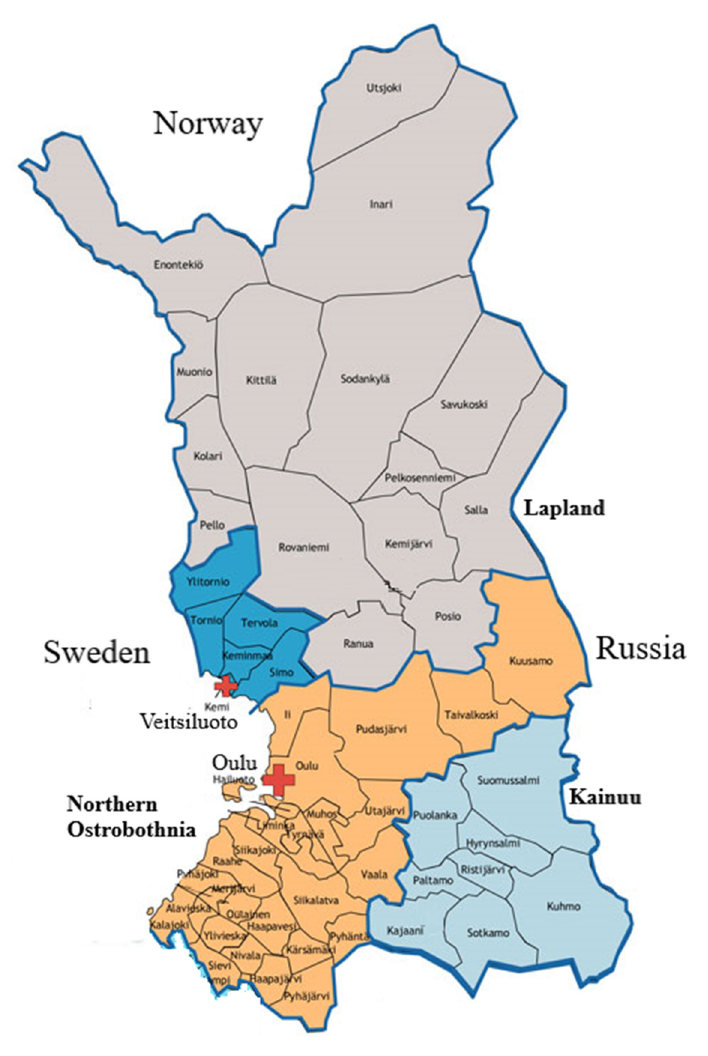
Figure 1. Wood procurement area for forest industry corporations in Lapland (grey and dark blue), Kainuu (light blue), and Northern Ostrobothnia (yellow), including their municipalities. Timber is exported from the dark blue area to Sweden, and the red crosses represent forest industry integrates.